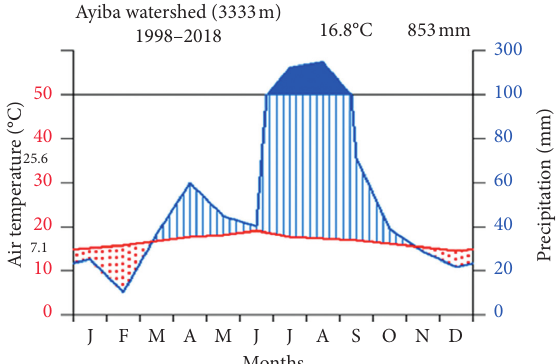
Figure 2: Climate diagram of the Ayiba watershed (data source: NMSAE [47]).